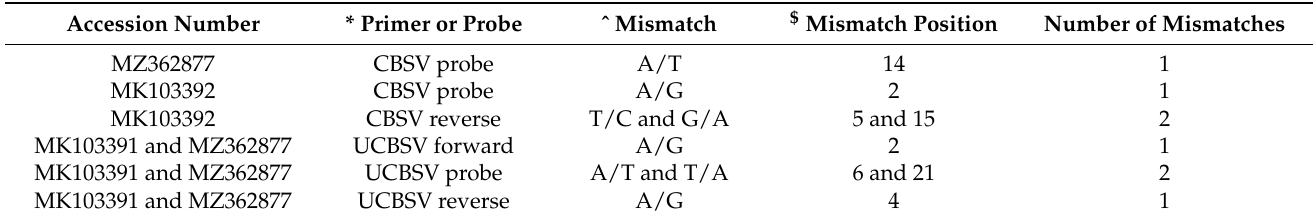
Table 5. Mismatches in primer/probe binding sites on sequences of cassava brown streak ipomovirus isolates from